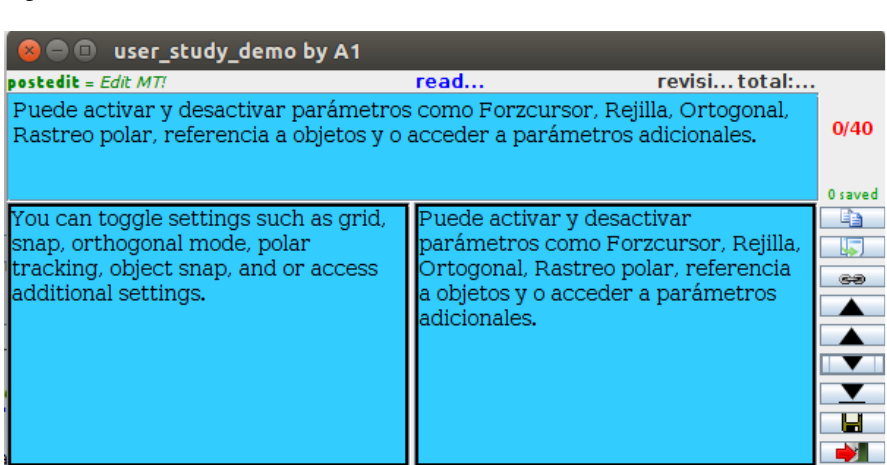
Figure 1. Translate from Scratch.